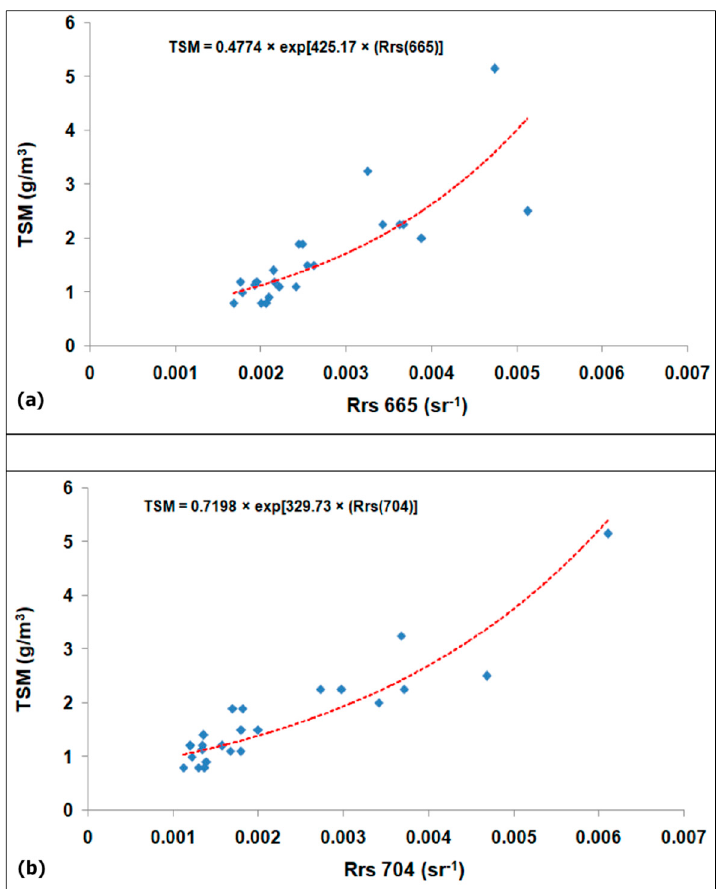
Figure 6. ( a ) Calibration of the TSM model based on Rrs at 665 nm. ( b ) Calibration of the TSM model based on Rrs at 704 nm. In the plots, the superimposed equations are the exponential “best-fitting” functions (dashed red line).